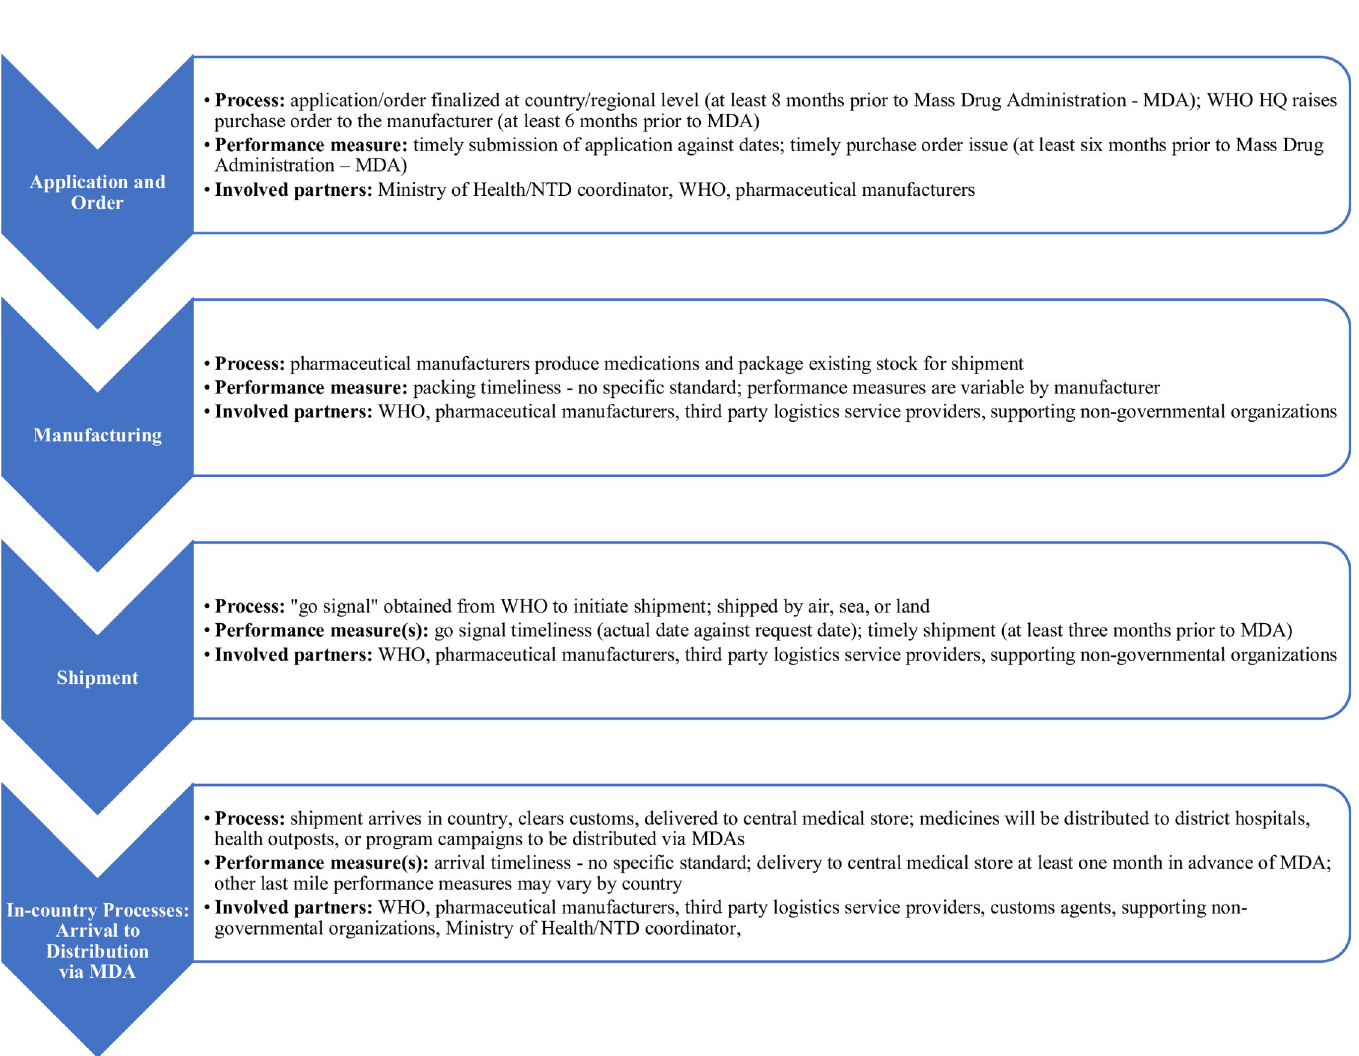
Fig 1. Components of the NTD supply chain from application for donation to in-country delivery to central medical stores.